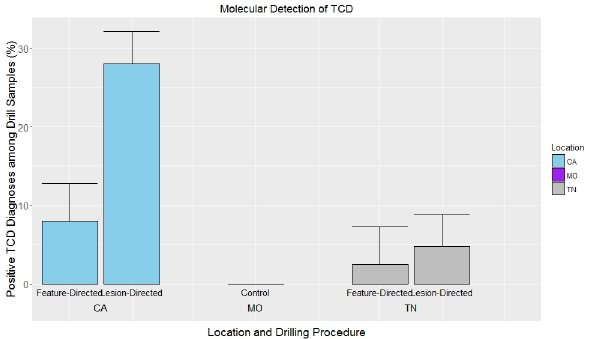
Fig 1. Molecular detection of thousand cankersdisease (percentage of positive drill samples) from both feature-directed and lesion-directed samples from California, Missouri (control), and Tennessee.